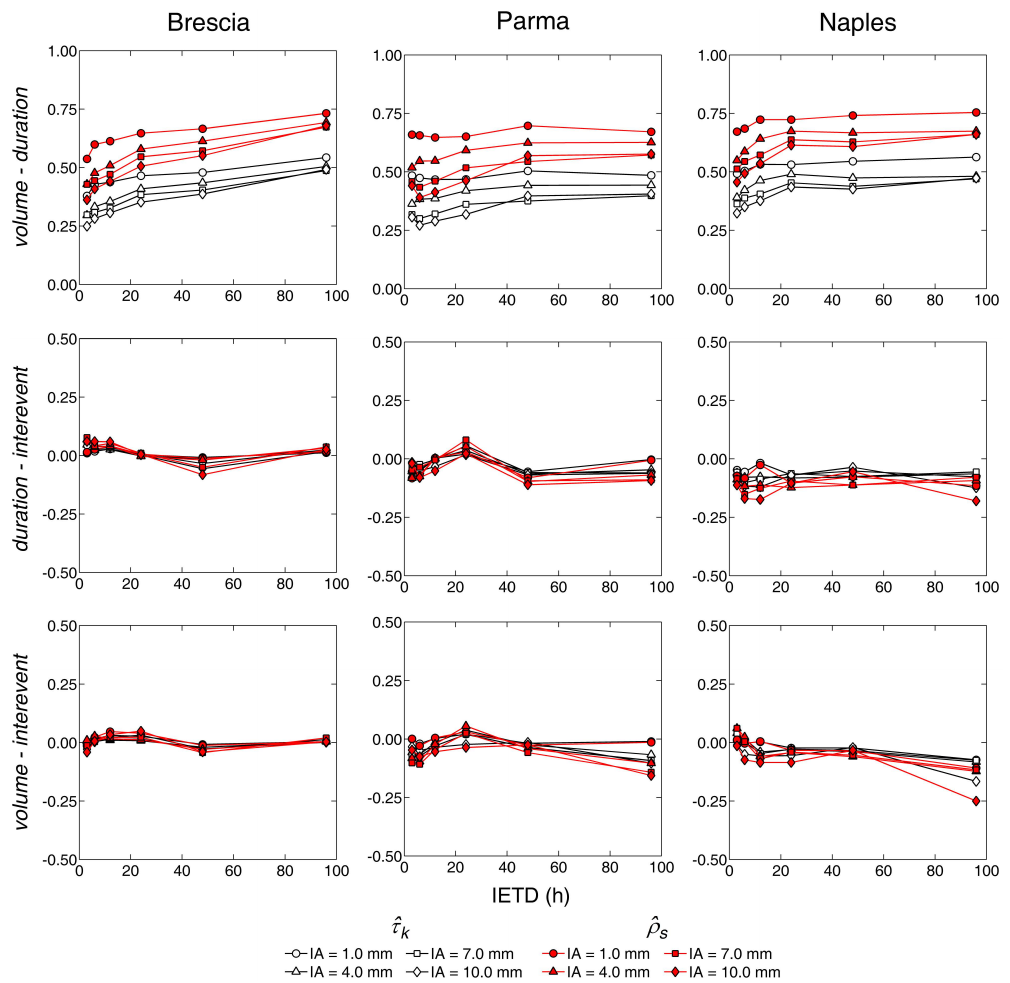
Fig. 2. Trends of the rank correlation coefficients according to the discretization